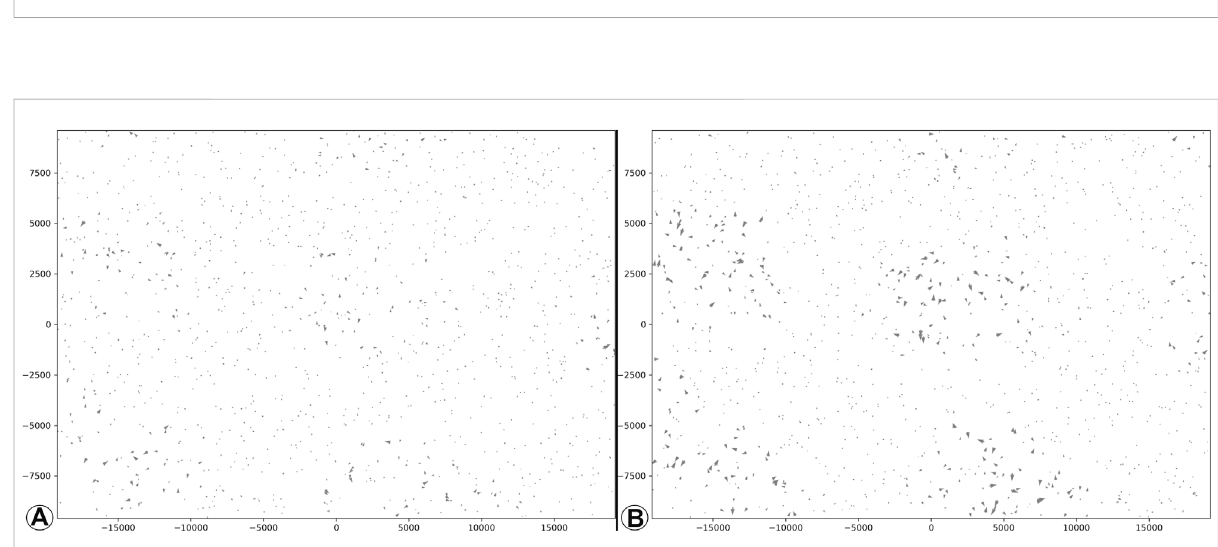
FIGURE 7 Illustrationof lacking correspondence in scale transformation on hedgehog plots: pre-scaling the arrow length ( V = D ◦ α ′ ◦ r 1 ◦ ω ; (A) differs from post-selection scaling ( V = D ◦ α ◦ r 1 ◦ ω ′ ; (B)